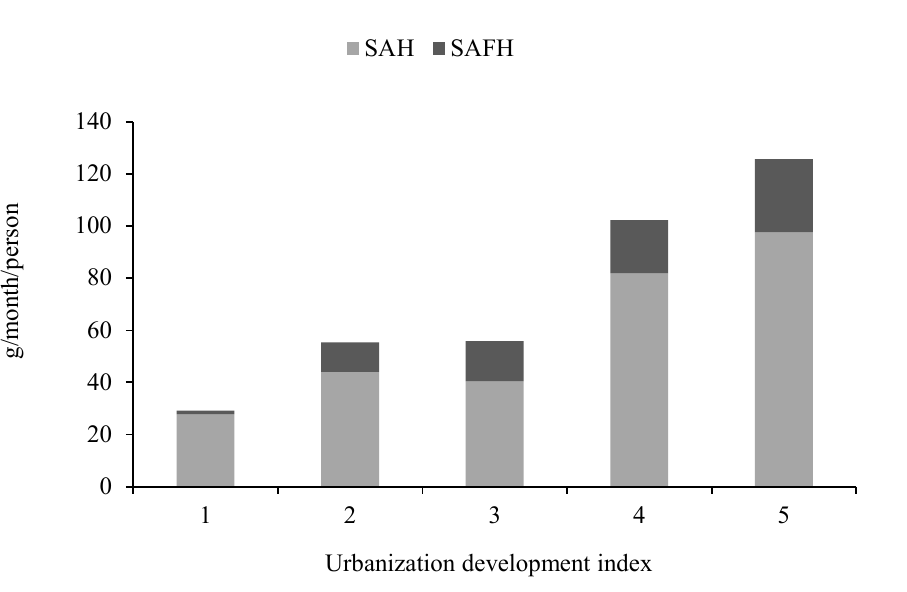
Figure 3. Seaweed consumption by UDI. Table 2. Sample size used in this study.